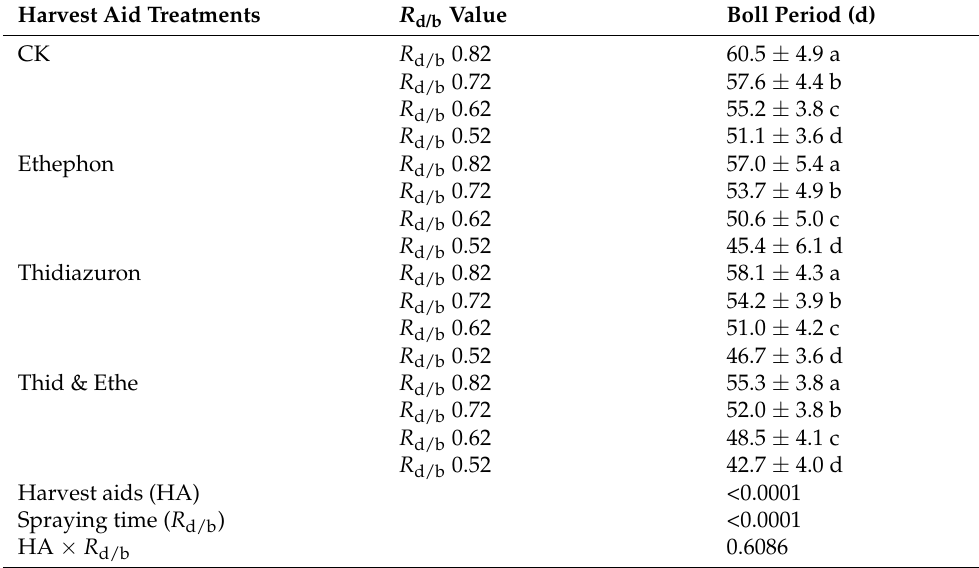
Table 2. Variance analysis of cotton boll periods under different harvest